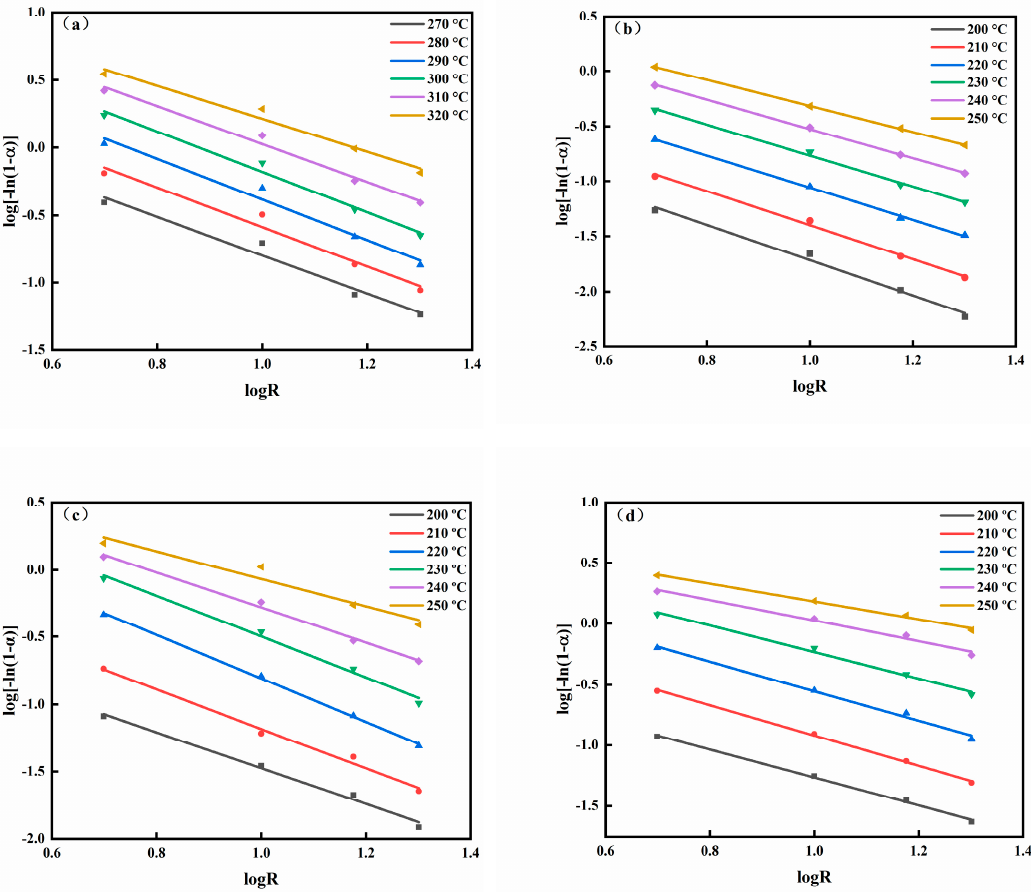
Figure 10. Avrami fitting plots of the non-isothermal curing at various temperatures in the neat ( a ), 4 ( b ), 8 ( c ), and 10 wt% ( d ) systems. Figure 10. Avrami fitting plots of the dynamic curing of cyanate ester (CE) systems at various temperatures. Table 2. Kinetic parameters obtained from Equation (9) at different temperatures under dynamic conditions for the neat system.